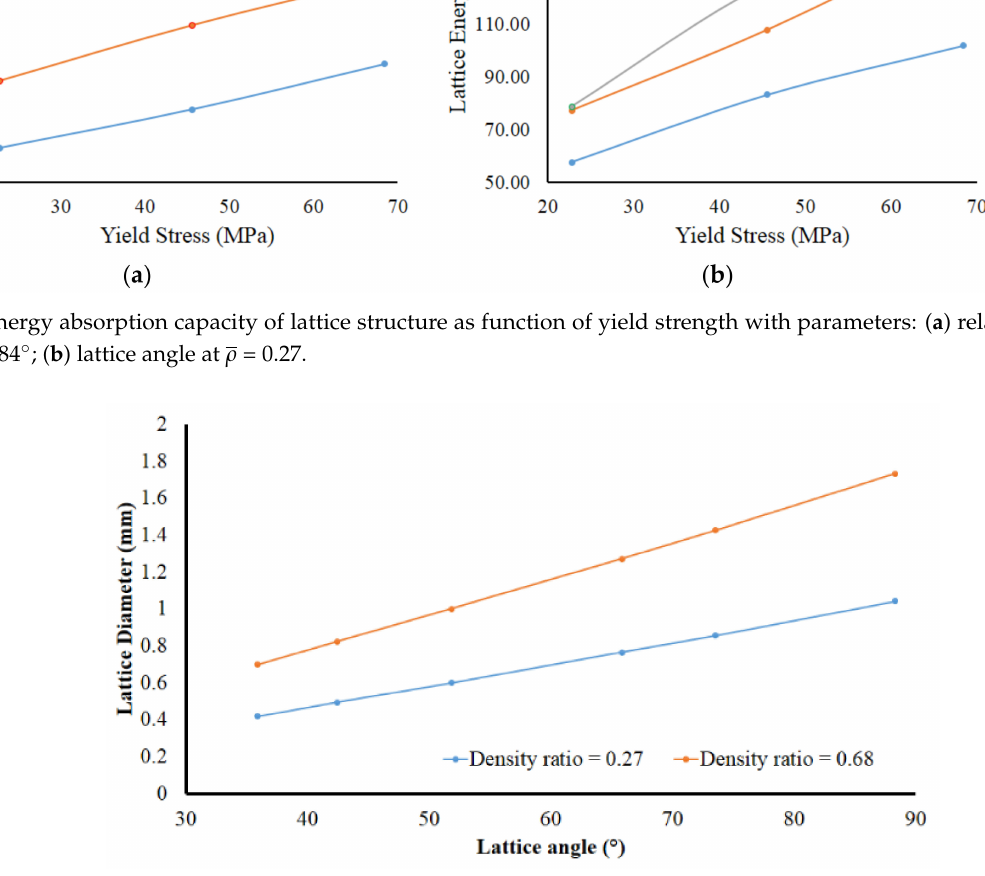
Figure 15. Diameter of lattice trusses as function of lattice angle at constant densities.